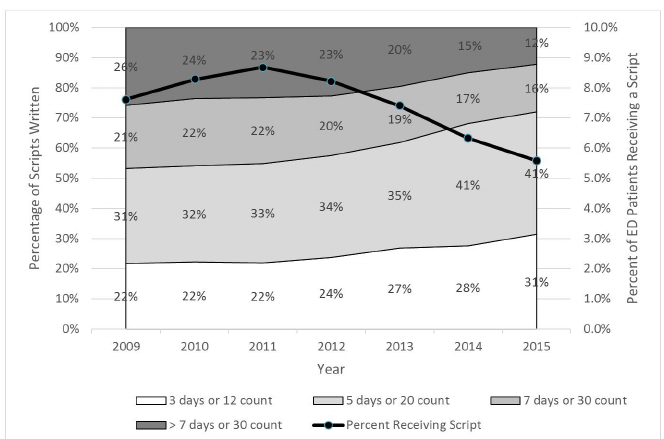
Figure 2. Hydrocodone/acetaminophen prescribing